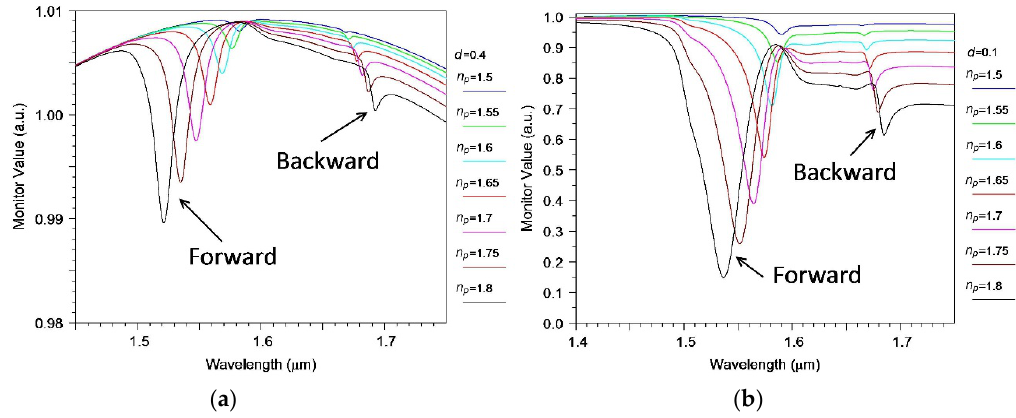
Figure 3. Transmission spectrum of a silicon waveguide in the presence of a periodic segmented structure made by a material with different refractive index surrounded by water for two thicknesses d of the buffer oxide layer between the waveguide and the segmental structure. ( a ) d = 0.4 µm; ( b ) d = 0.1 µm. The grating period is 1.3 µm.